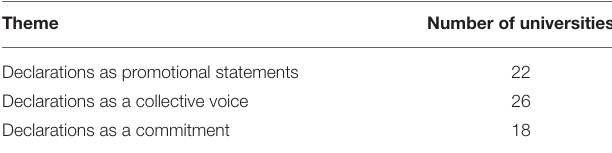
TABLE 2 | Distribution of universities across each theme.